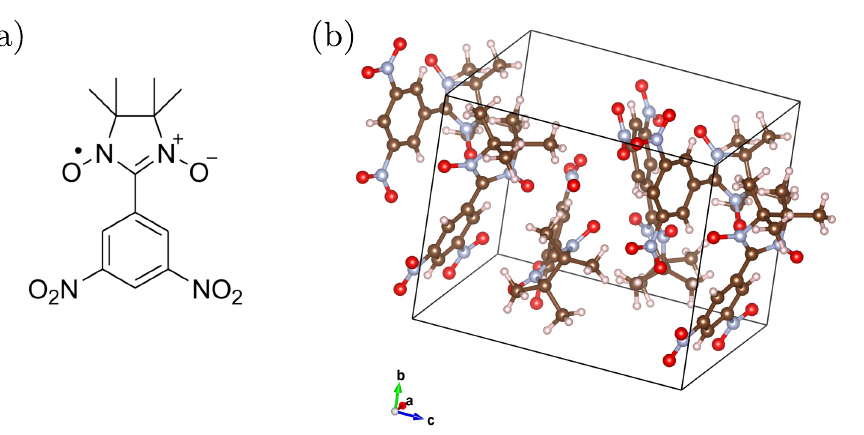
Figure 1. ( a ) The molecular structure of DNPNN. ( b ) The crystal structure of one enantiomorph of DNPNN (the other enantiomorph is the mirror image of this). The atoms are colour-coded, as follows: carbon (brown), oxygen (red), nitrogen (grey), and hydrogen (pale pink and